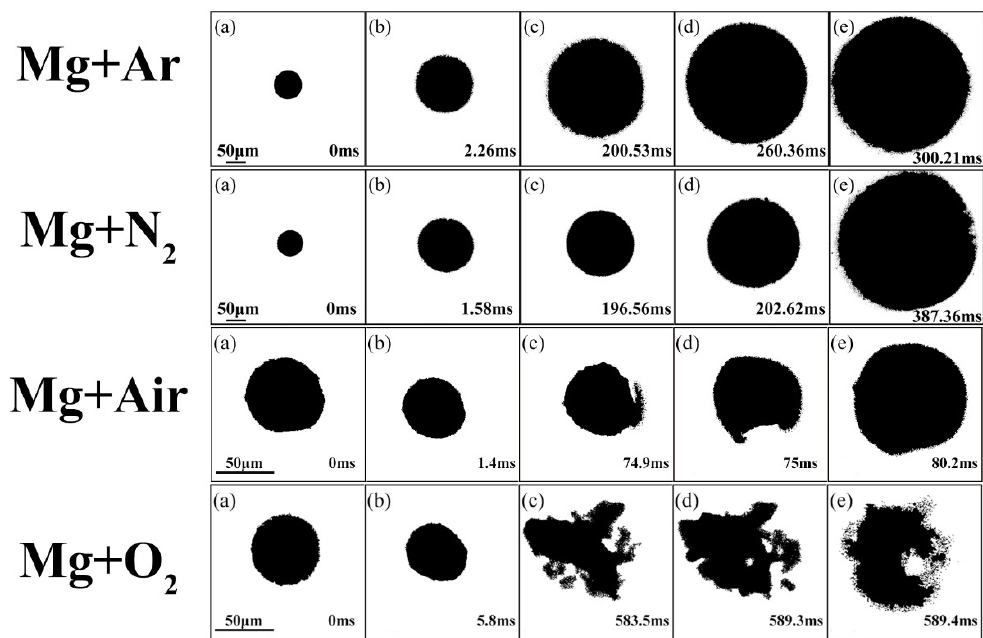
Figure 4. Representative snapshots of gasification of Mg microparticles and diffusion process of Mg vapor in inert and oxidizing atmospheres.